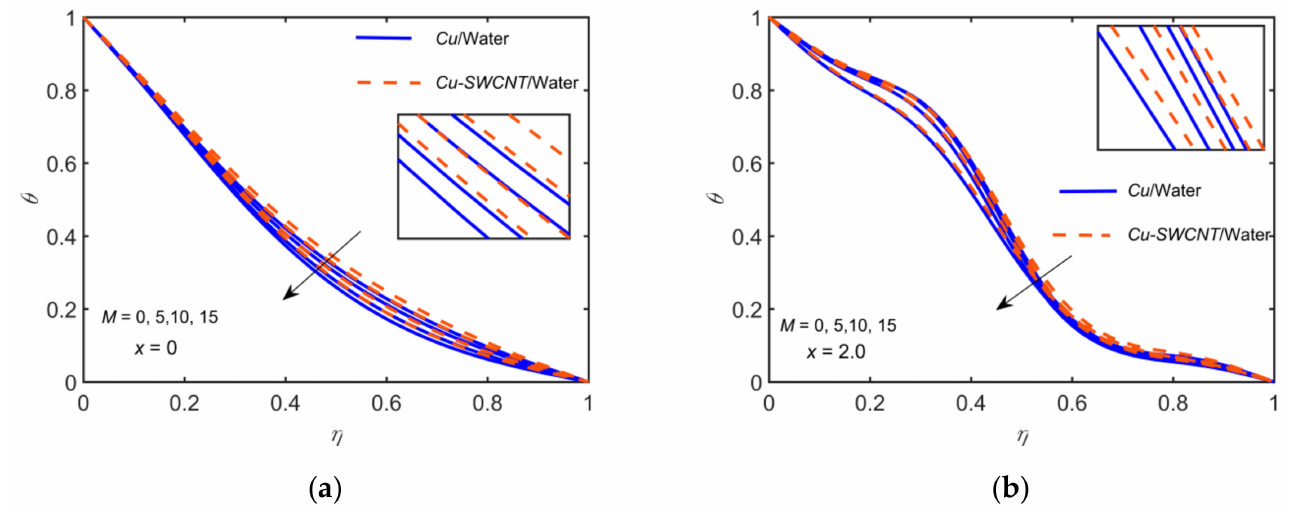
Figure 9. Comparison of Cu /water and Cu – SWCNT /water for the temperature profiles for M = 0, 5, 10, and 15 with St = 0.02, Pr = 1, Rd = 0.2, Re = 700, φ = 0.02, and t = 0.25 at ( a ) x = 0 ( b ) x = 2.